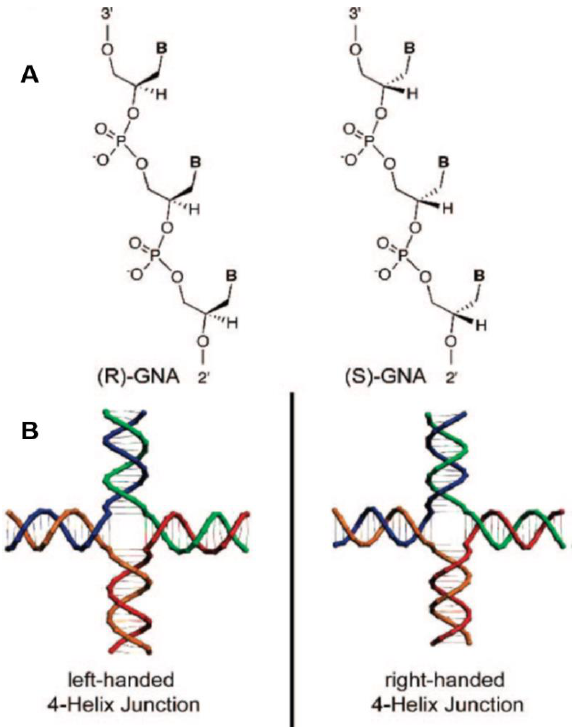
Figure 14. An immobile 4-helix junction comprising of GNA: (A) The chemical structures of (R)- and (S)-GNA, where ‘B’ in the structure of figure A means a nucleobase and (B) left and right-handed 4- helix structure of GNA. Figure reproduced with permission from [169]; Copyright © 2008, American Chemical Society.